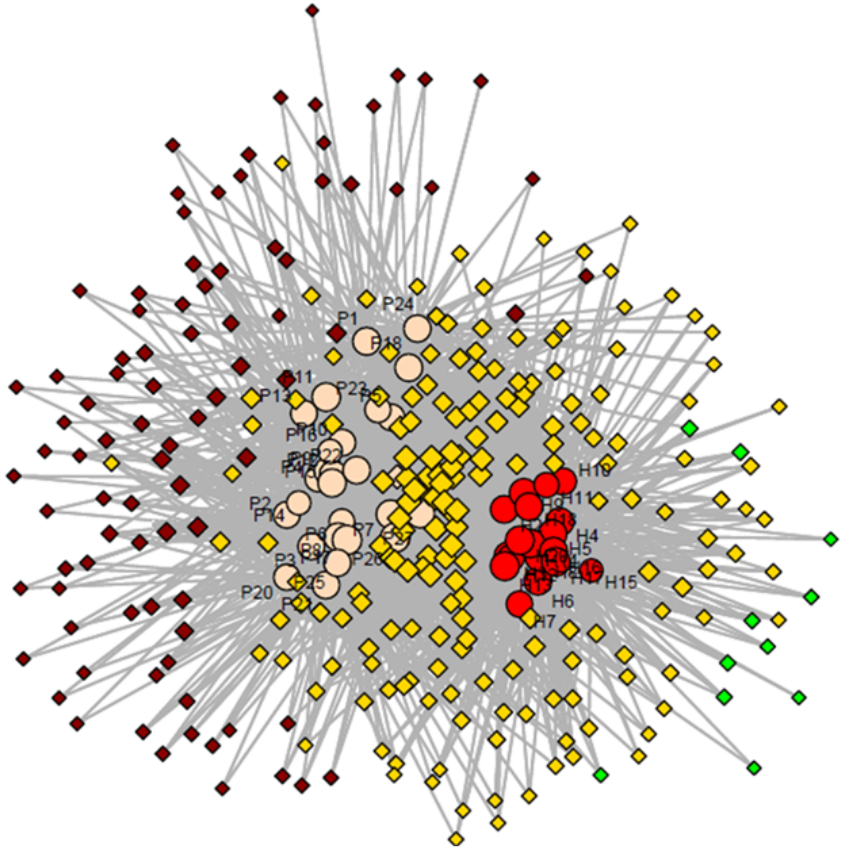
Figure 2. Network analyses presenting separation between the two investigated groups based on the VOCs specific for patients with glomerular diseases (brown diamonds), VOCs common between groups (yellow diamonds) and VOCs characteristic for healthy group (green diamonds), where H 1 to 20 represents the number of healthy control and P 1 to 27 the number of patients.